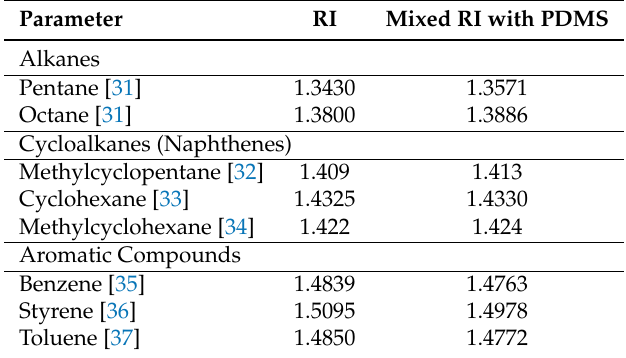
Table 9. List of hydrocarbon compounds composing crude oil and their respective